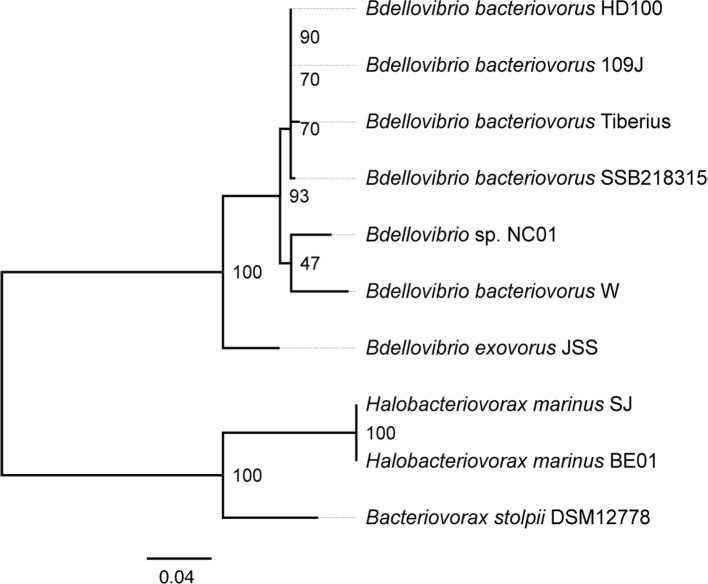
16S rRNA gene phylogenetic tree. We aligned 16S rRNA gene sequences using sina 1.2.11, then constructed a phylogenetic tree using RAxML BlackBox with 100 bootstrap replicates. The phylogenetic tree is rooted on the branch joining
Bdellovibrio
 with
Bacteriovorax
/
Halobacteriovorax
, and bootstrap support for each node is shown.